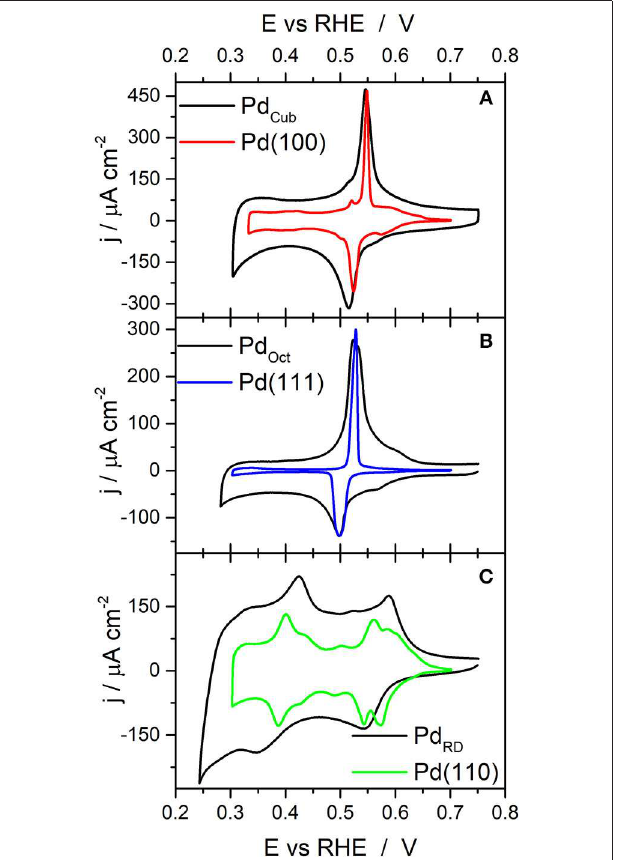
FIGURE 6 | Cu UPD deconvolution with pseudo-Voigt function for the (A) Pd Cub , (B) Pd Oct , and (C) Pd RD nanoparticles. Test solution 0.1M H 2 SO 4 + 1mM Cu 2 + + 1mM NaCl, scan rate 50mV s − 1